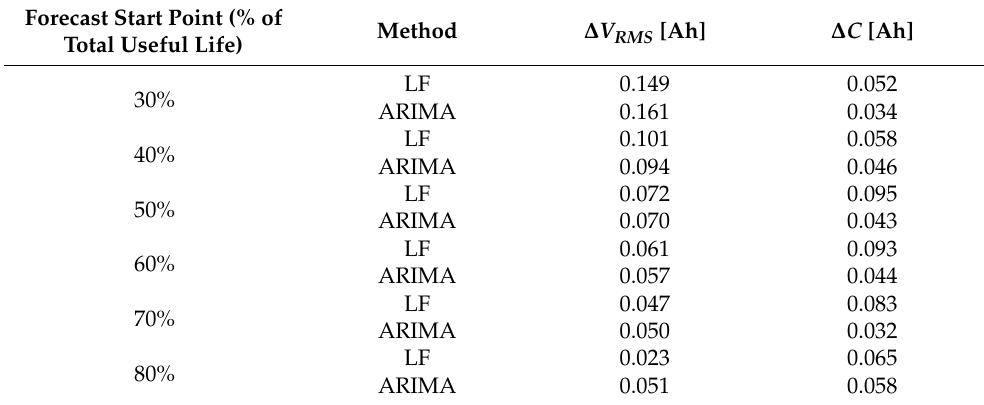
Table 5. Comparative RMSE results between the proposed health indicator ∆ V RMS and the capacity fade ∆ C with respect to the measured capacity fade ∆ C (objective time series) for cell B0034 with a discharge current of 4 A (C-rate of